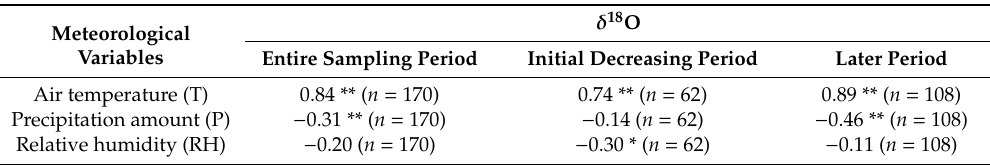
Table 2. Statistics of the correlations between the meteorological variables and δ 18 O in precipitation over short-term